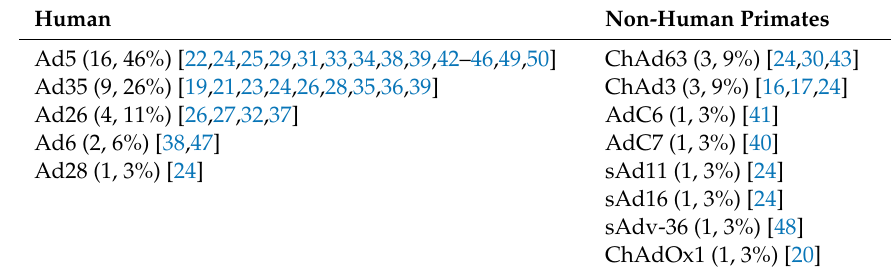
Table 2. The number and percentage of papers that included dose-response data for each adenovirus serotype.